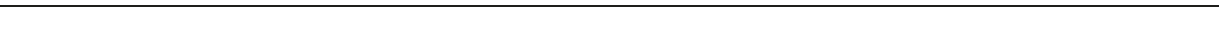
Fig. 6 UBR5 maintains proteostasis of HTT but not ATXN3 in iPSCs. a Western blot analysis of HD Q71-iPSC line #1 with antibody to HTT. The graph represents the nHTT and mHTT relative percentage values (corrected for β -actin loading control) to NT shRNA iPSCs (mean ± s.e.m. of three independent experiments). b Immunocytochemistry of HD Q71-iPSC line #1 upon knockdown of the indicated proteostasis components. PolyQ-expanded and Hoechst 33342 staining were used as markers of aggregates and nuclei, respectively. Scale bar represents 10 μ m. The images are representative of three independent experiments. c Western blot analysis with antibodies to HTT and ATXN3 of iPSCs derived from two individuals with MJD (MJD-iPSC lines #1 and #2) and control iPSCs. Anti-ATXN3 antibody detects both normal (nATXN3) and mutant ATXN3 (mATXN3). Proteasome inhibitor treatment: 5 µ M MG-132 for 6 h. The graphs represent the HTT, nATXN3, mATXN3 relative percentage values to the respective DMSO-treated iPSCs corrected for β -actin loading control (mean ± s.e.m. of three independent experiments). d Immunocytochemistry of control iPSCs #2, MJD-iPSC lines #1 and #2 upon proteasome inhibition (5 µ M MG-132 for 6 h). PolyQ-expanded and Hoechst 33342 staining were used as markers of aggregates and nuclei, respectively. Scale bar represents 10 μ m. The images are representative of three independent experiments. e , f Western blot analysis with antibodies to HTT and ATXN3 of MJD-iPSC lines #1 and #2 upon UBR5 knockdown. The graphs represent the relative percentage values of HTT, nATXN3 and mATXN3 to the respective NT shRNA iPSCs corrected for β -actin loading control (mean ± s.e.m. of three independent experiments for each line). g Immunocytochemistry of MJD-iPSC lines #1 and #2 upon UBR5 knockdown. Proteasome inhibitor: 5 µ M MG-132 for 6 h. PolyQ-expanded and Hoechst 33342 staining were used as markers of aggregates and nuclei, respectively. Scale bar represents 10 μ m. The images are representative of three independent experiments. All the statistical comparisons were made by Student ’ s t -test for unpaired samples. * P < 0.05, ** P < 0.01, *** P <